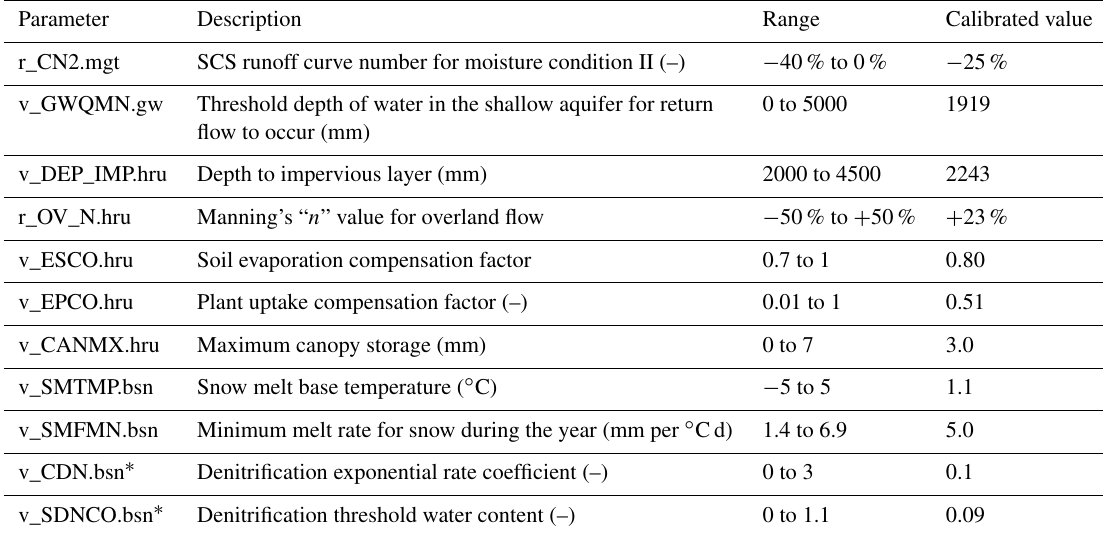
Table 2. Calibrated parameters for streamflow and NO − v – absolute change, r – relative change.